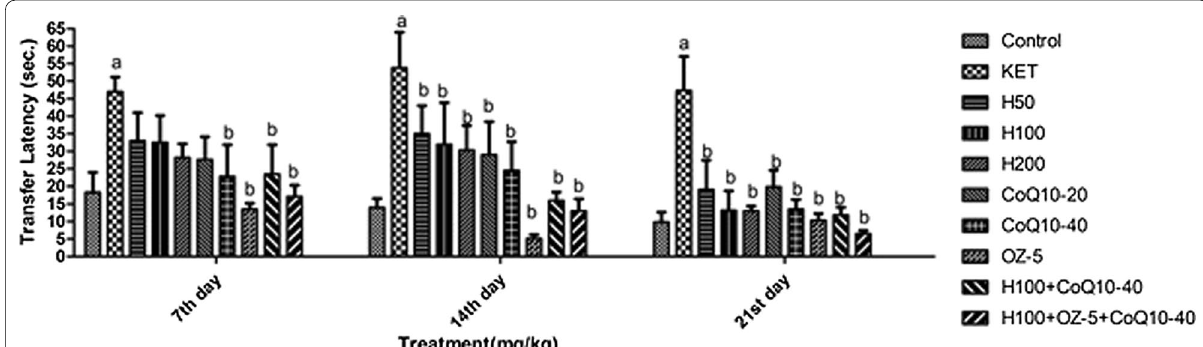
Initial Acquisition Latency, 1st RTL First = =